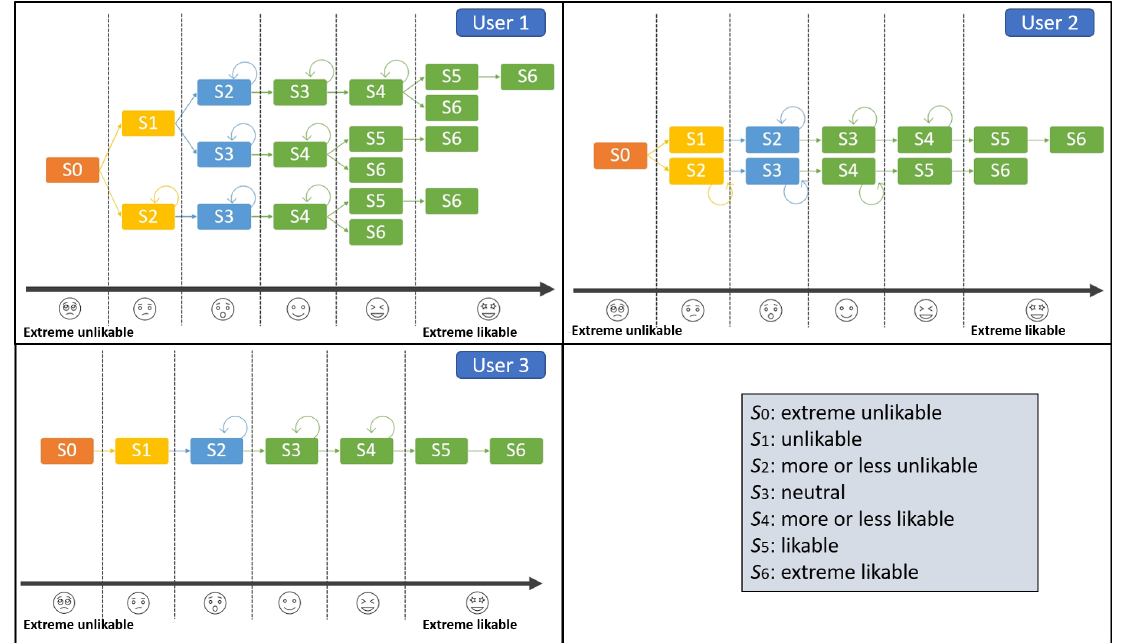
Figure 16. User simulation state transition. User 1 with a learning rate of 0.4. User 2 with a learning rate of 0.6. User 3 with a learning rate of